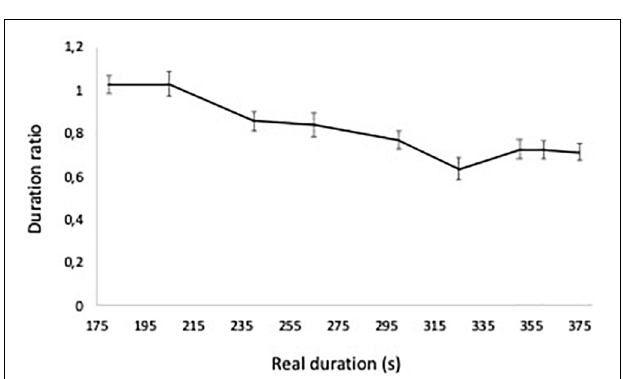
FIGURE 1 | Average estimated durations across real time.